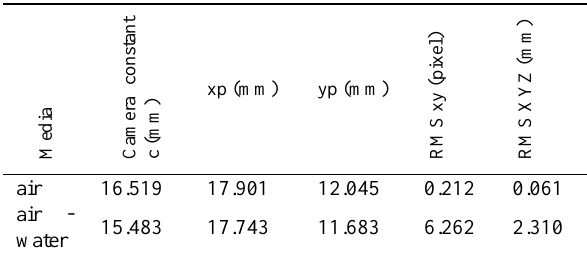
Table 2. Camera Calibration results in air and air-water in field conditions (Georgopoulos and Agrafiotis, 2012)